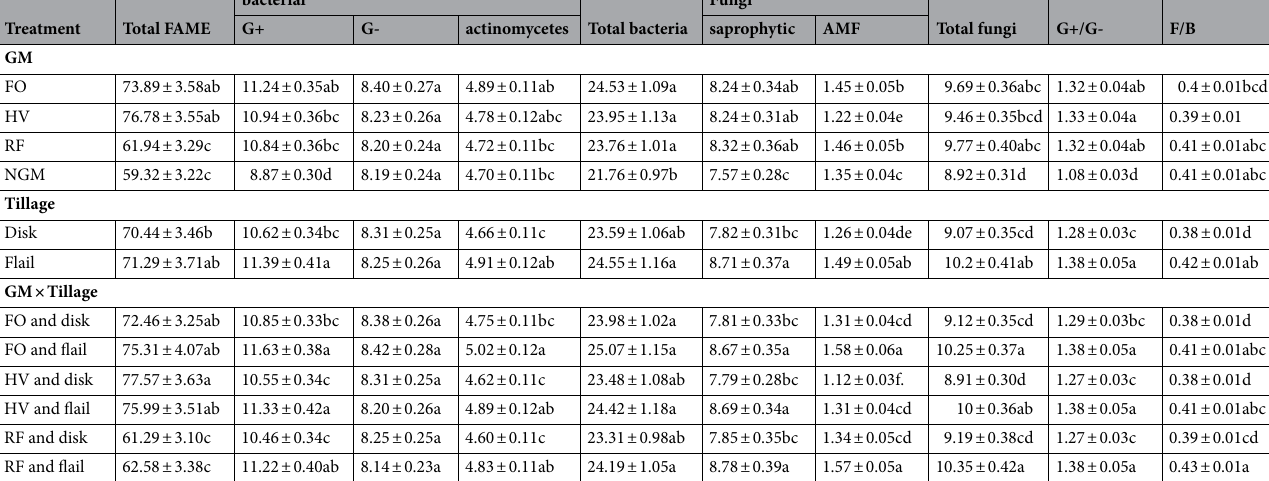
Table 2. Microbial community composition according to FAME profiles as affected by green-manure and the termination method. Small letters within a column reflect differences between treatments (LSD test, P < 0.05). The P values of ANOVA are shown in Table S4. G + gram positive bacteria, G − gram negative bacteria, AMF arbuscular mycorrhizal fungi, G + /G − gram positive bacteria: gram negative bacteria ratio, F/B fungi: bacteria ratio, GM green manure; FO February orchid; HV hairy vetch; RF rattail fescue; NGM no green